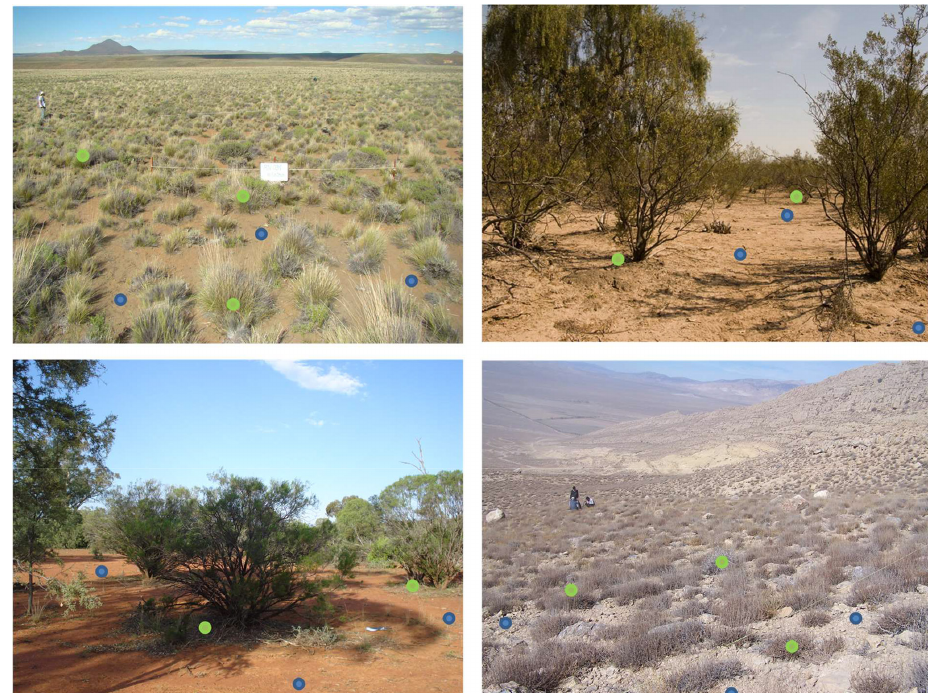
Figure 14. Examples of placement of sampling points in open (blue) and vegetated (green) microsites in different dryland vegetation types (in the examples shown there are no biocrusts). Please note that the location of the sampling points in the pictures is made for illustration purposes only and are not located at a proper scale. A minimum separation distance between samples and between open and vegetated microsites should be established (see the main text for details). Photograph credits: Juan Gaitán, Eduardo Pucheta, David Eldridge and Mohamad